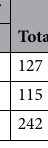
Table 6. Comparison between retinal microvascular abnormalities and VPT. VPT Vibration perception threshold.